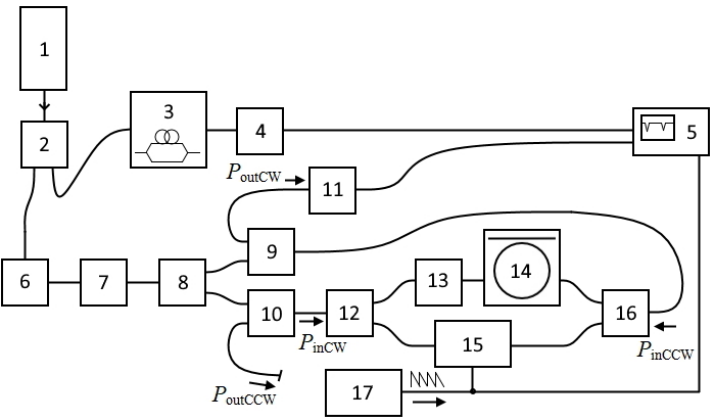
Figure 6. Diagram of an optical resonator gyroscope with a Mach – Zehnder modulator.